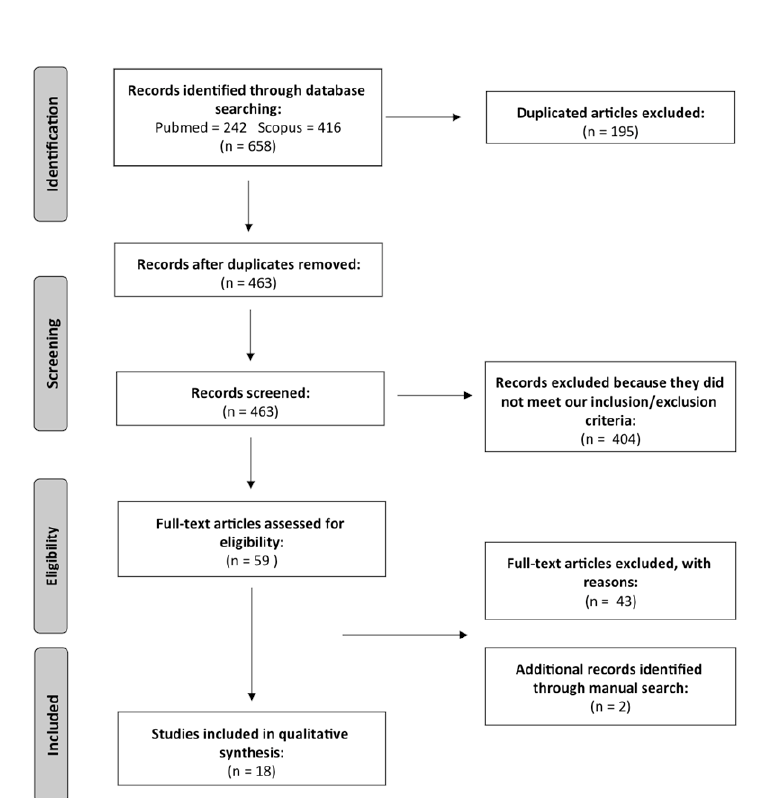
Figure 1. The Preferred Reporting Items for Systematic Reviews and Meta-Analyses (PRISMA) workflow. Eighteen studies were considered for this systematic